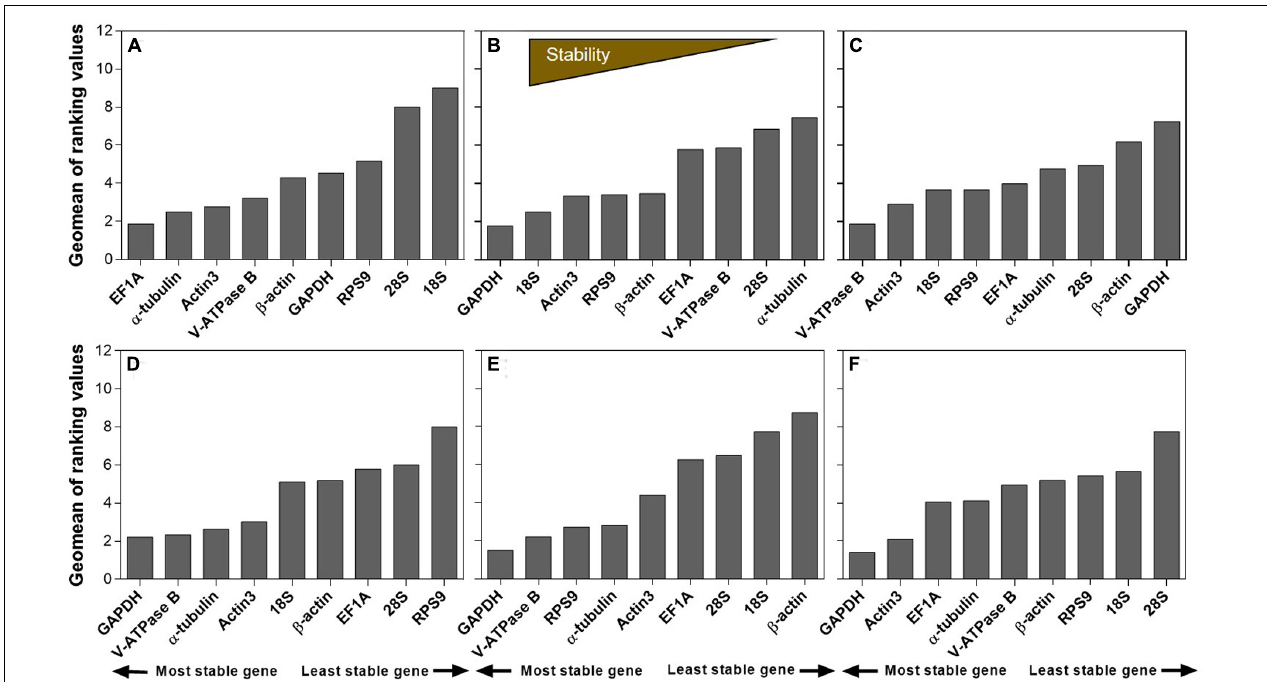
FIGURE 3 | Expression stability of candidate reference genes under different experimental conditions in A. viennensi . The extrinsic conditions including temperature (A) , humidity (B) , photoperiod (C) , host plant (D) , dietary RNAi (E) , and all the selected extrinsic conditions (F) . The final stability ranking was provided by ReFinder, which is a comprehensive platform integrating all four algorithms used in this study. A lower Geomean value suggests stable expression.